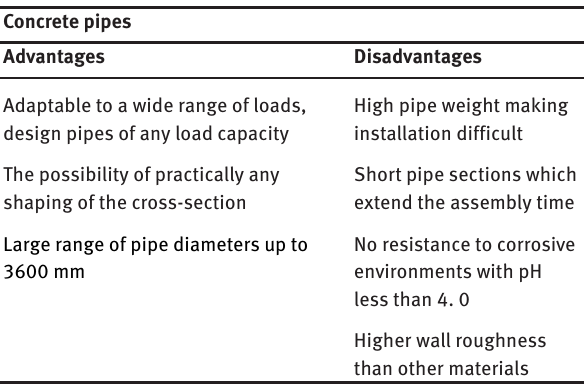
Table 1: Advantages and disadvantages of concrete